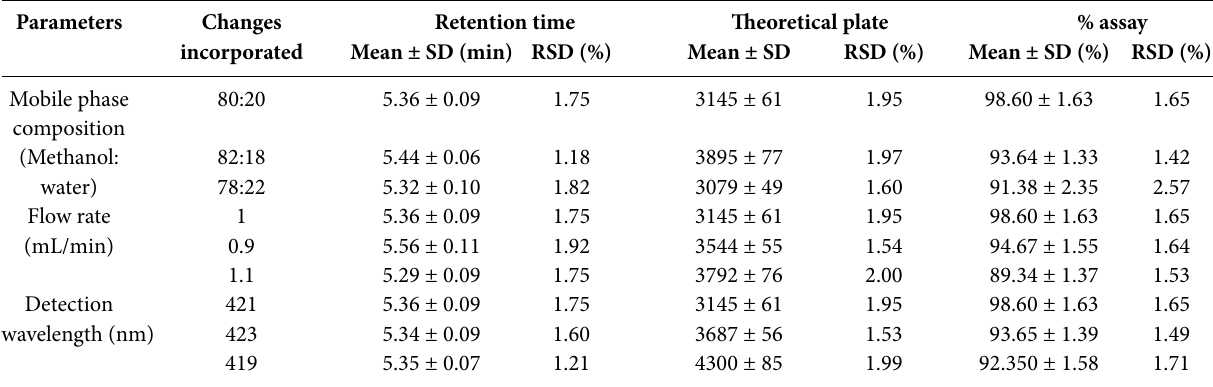
Table 4. Robustness and ruggedness evaluation of the developed method for curcumin